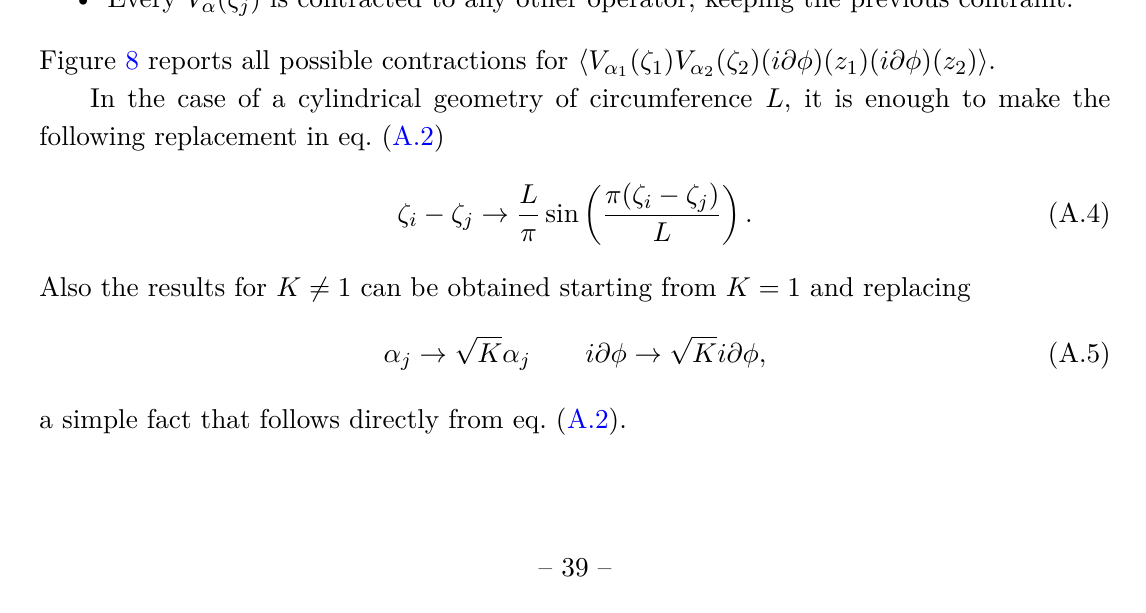
( ζ ) V ( ζ )( i∂φ )( z 1 α 2 2 1